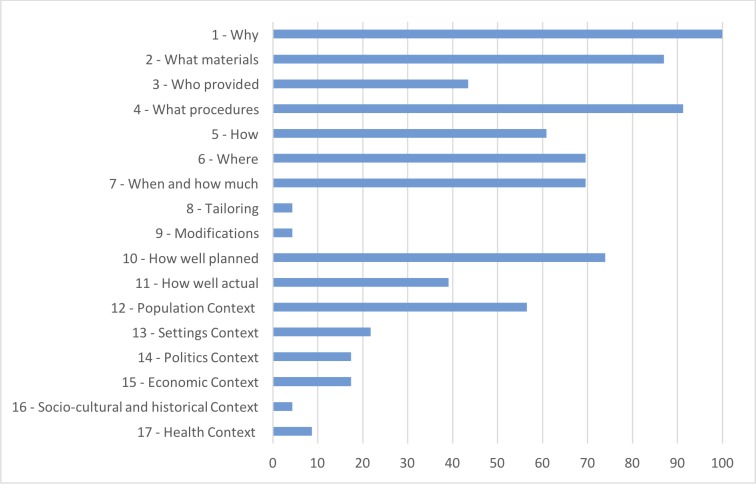
Tidier checklist.